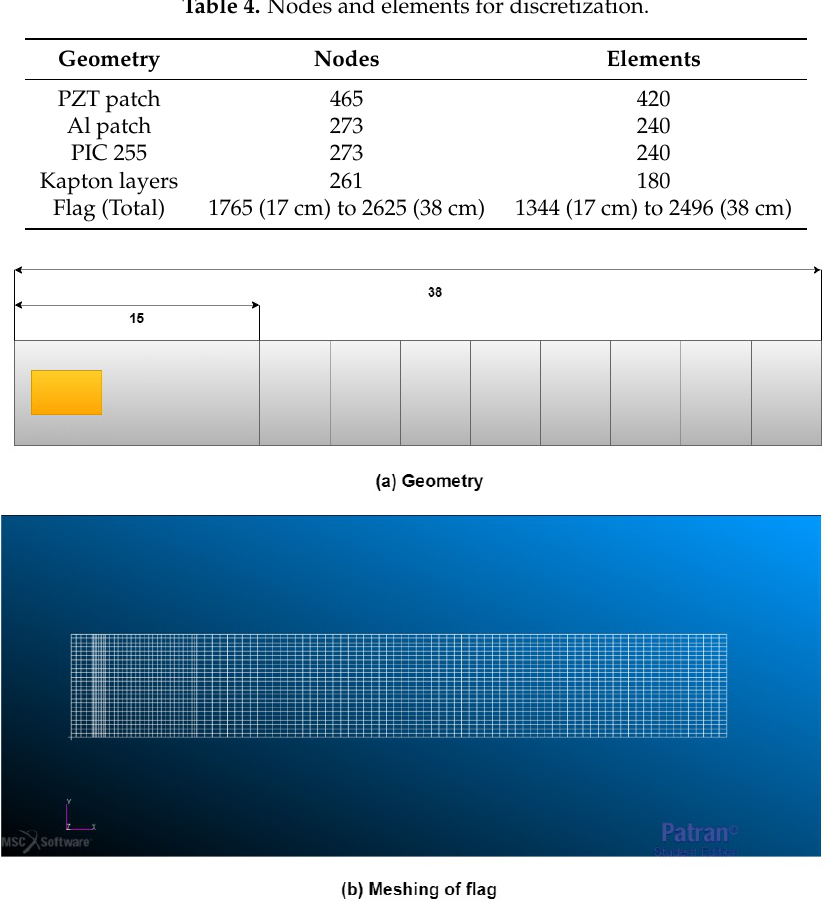
Figure 2. Numerical analysis of the flag-flutter mechanism based on flutter